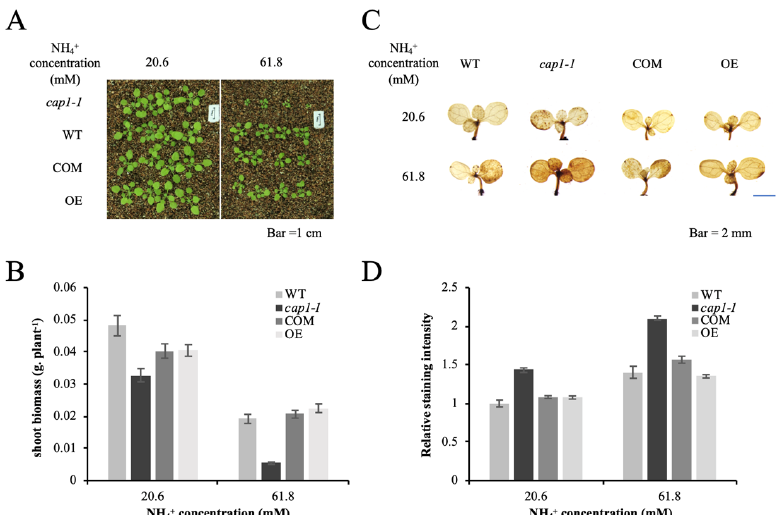
Figure 6. CAP1 transgene line suppress the hypersensitivity of cap1-1 to NH 4+ . ( A ) Growth of the OE, COM, WT, and the cap1-1 mutant in response to different growth condition. Scale bars = 1 cm. ( B ) Shoot fresh weights of WT and cap1-1 plants in ( A ) were averaged. Seven-day-old seedlings were transplanted to a pot containing only vermiculite. Solutions containing 20.6 mM and 61.8 mM NHCl 4 were applied to the respective plants for about 4 weeks, and then pictures were taken. Values are the means ± SE, n = 8–11. (Independent samples t -test.) ( C ) Detection of H 2 O 2 levels in WT and cap1-1 leaves. Seven-day-old seedlings were grown on 2 different media with 20.6 and 61.8 mM NH 4+ for 3 d, and then DAB staining of shoots was performed. ( D ) The mean relative DAB staining intensity in the WT and cap1-1 leaves in ( C ). WT grown on MS medium (20.6 mM NH 4+ ) was set as 1. Values are the means ± SE, n = 24–33 (independent samples t -test).